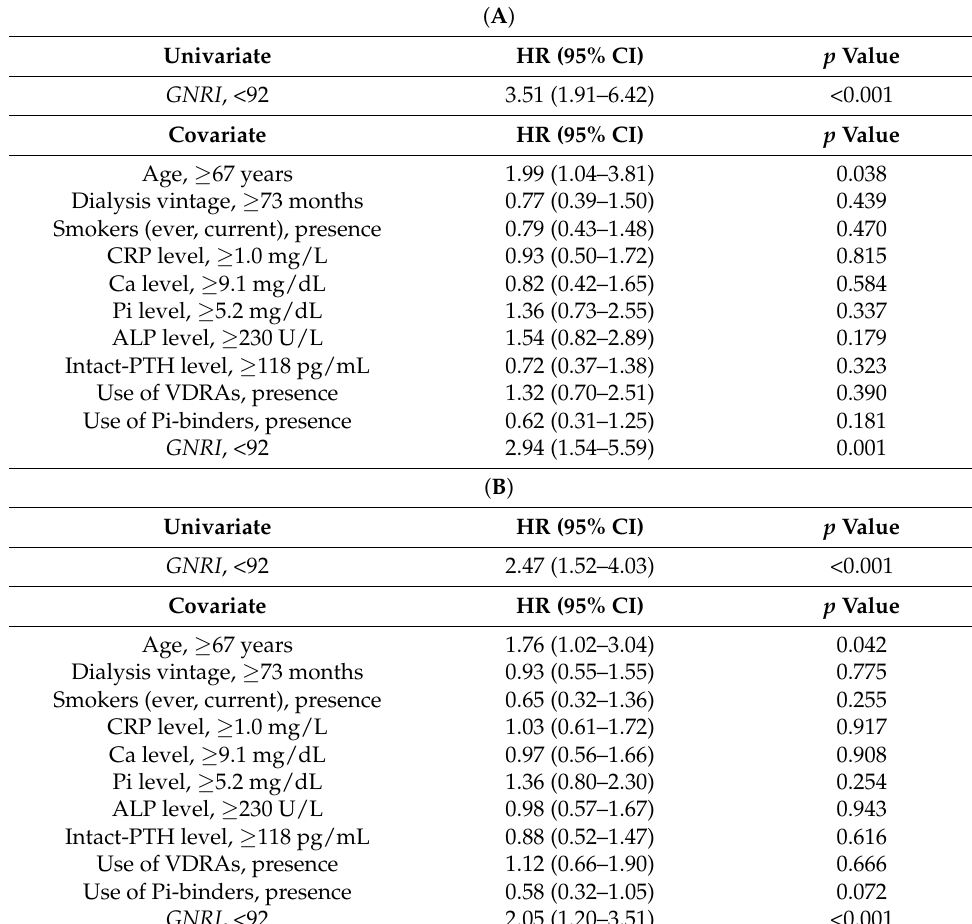
Table 3. Hazard ratios for bone fractures in ( A ) males and ( B )